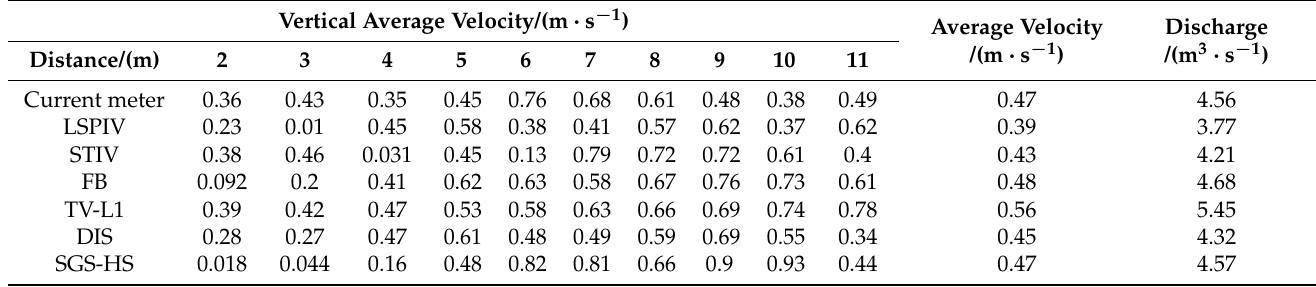
Table 2. Comparison of the results of the six algorithms and the current